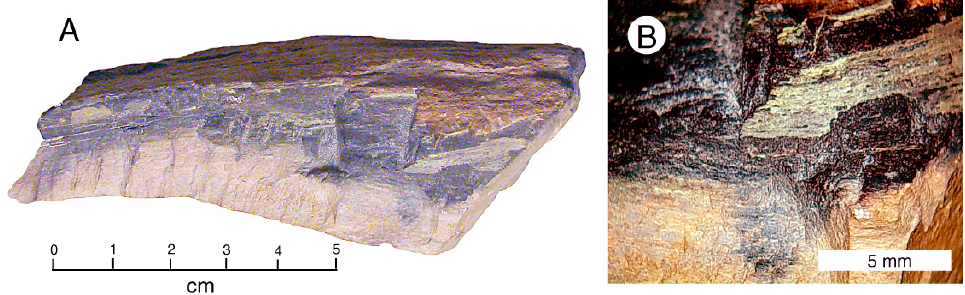
Figure 6. Uraniferous silicified wood, Holbrook (AZ, USA). ( A ) Light brown wood and dark gray uranium rich zone. ( B ) Fracture planes in dark gray zone contain thin coatings of a secondary uranium mineral, possibly tyuyamunite.